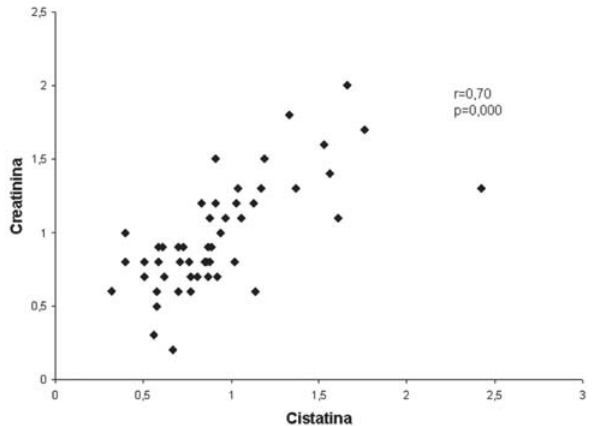
Tabela 3. Média e desvio-padrão dos valores de creatinina,